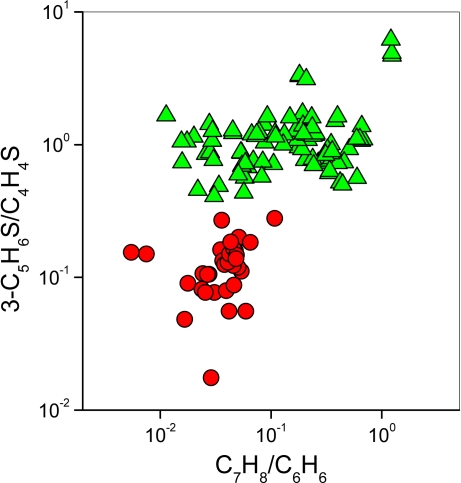
3-C5H6S/C4H4S vs. C7H8/C6H6 binary diagram. Symbols as in Figure 2.